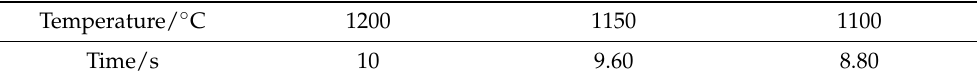
Table 4. Time cost during water cooling from 1200 ◦ C, 115 ◦ C and 1100 ◦ C (s).